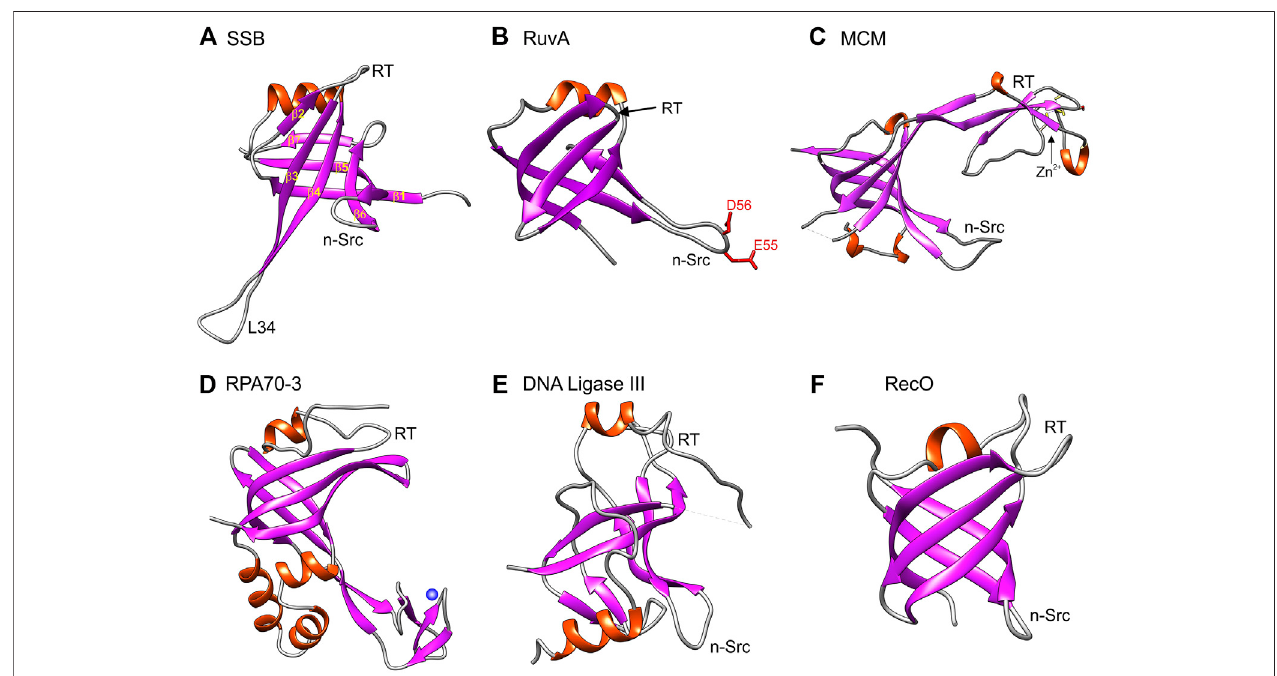
FIGURE 2 | The OB-fold in genome guardians presents itself in different forms. Six representative OB-folds are shown. Panels A, B and F are prokaryotic while panels (C – E) arefromeukaryoticproteins.Asin Figure1 ,imagesweregeneratedusingChimerawithhelicescoloredredand β -sheetsinpurple.Theorientationofeach OB-fold is the same as in (A) such that the α -helix is located at the top of each structure to enable direct visual comparison. (A) SSB is the single-strand binding protein from E.coli (PDB fi le1EYG); (B) RuvAispartofthe E.coli HollidayJunctionbranchmigrationcomplex(PDB fi le1C7Y); (C) TheOB-foldfromoneofthesubunitsofa homohexameric MCM hexamer (PDB fi le 4ME3). (D) is the third OB-old present in the 70 kDa subunit of the eukaryotic Replication Protein A (functional homologue of E. coli SSB) (PDB fi le 4GOP); (E) is the OB-fold from DNA ligase III (PDB fi le 3L2P) and (F) is the OB-fold from RecO, a recombination mediator also from E. coli (PDB fi le